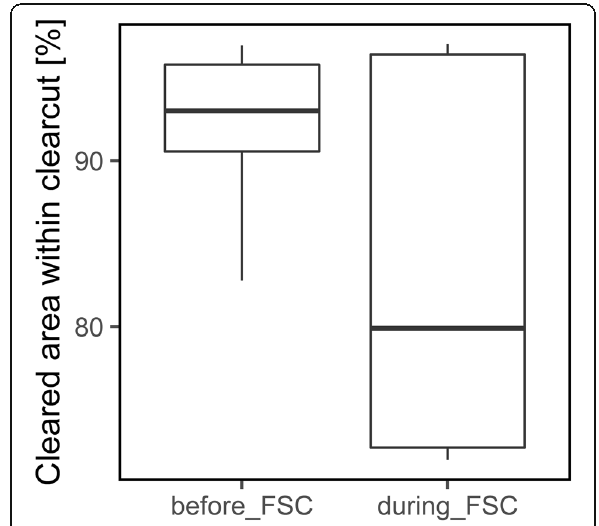
Fig. 5 Share of cleared area within the studied clearcuts before FSC